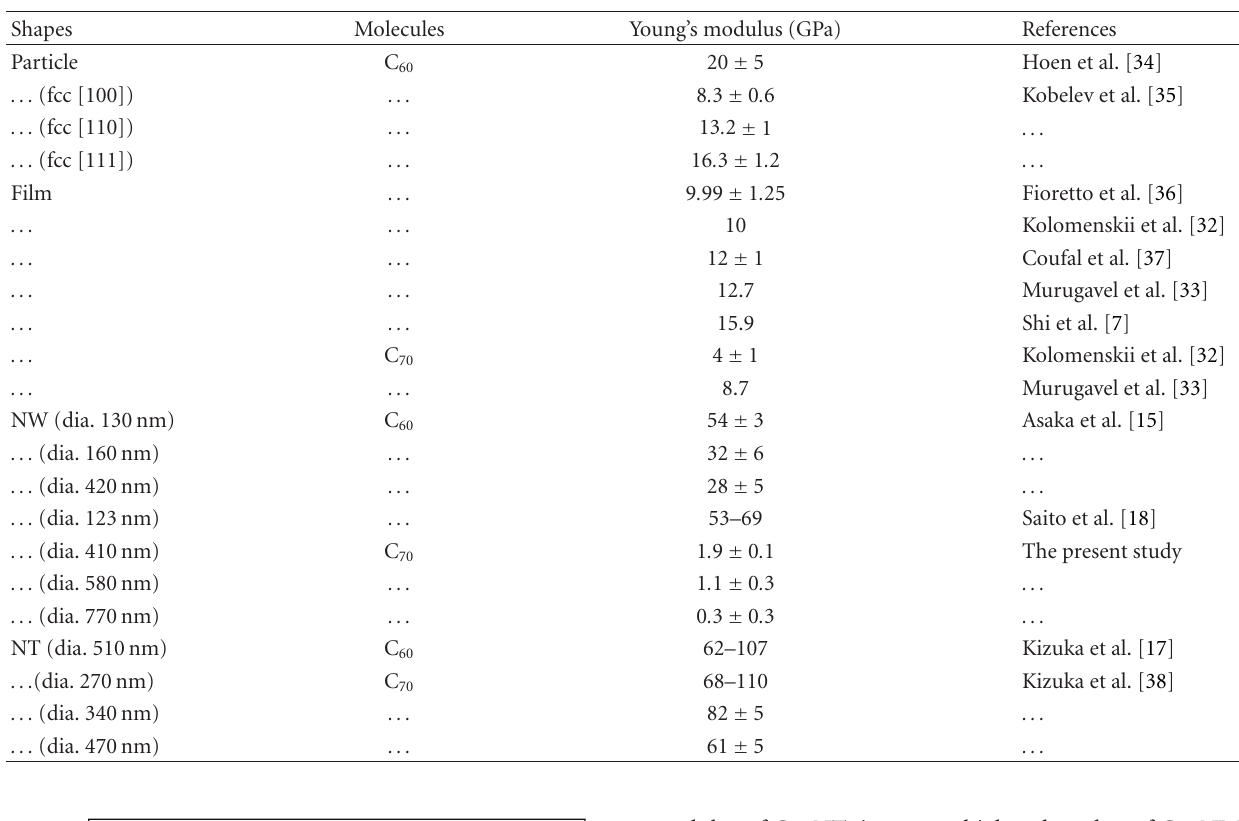
Table 1: Young’s modulus of fullerene crystals (NW: nanowhisker; NT: nanotube).